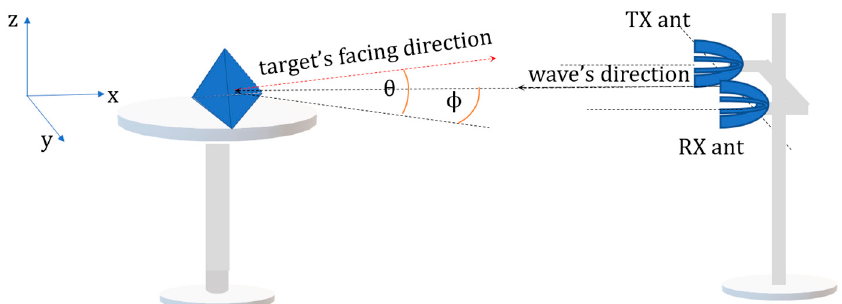
Figure 2. Definitions of angles used in this work. The elevation angle θ is the angle between the target’s facing direction and the horizontal plane. The aspect angle ϕ is the electromagnetic (EM) wave incident angle in the azimuth point of view (in other words, the angle between the target’s facing direction and the vertical plane). Every measurement case in this study shall be done with θ = 0° and –90° ≤ ϕ ≤ 90°. Table 1. List of targets and their descriptions.